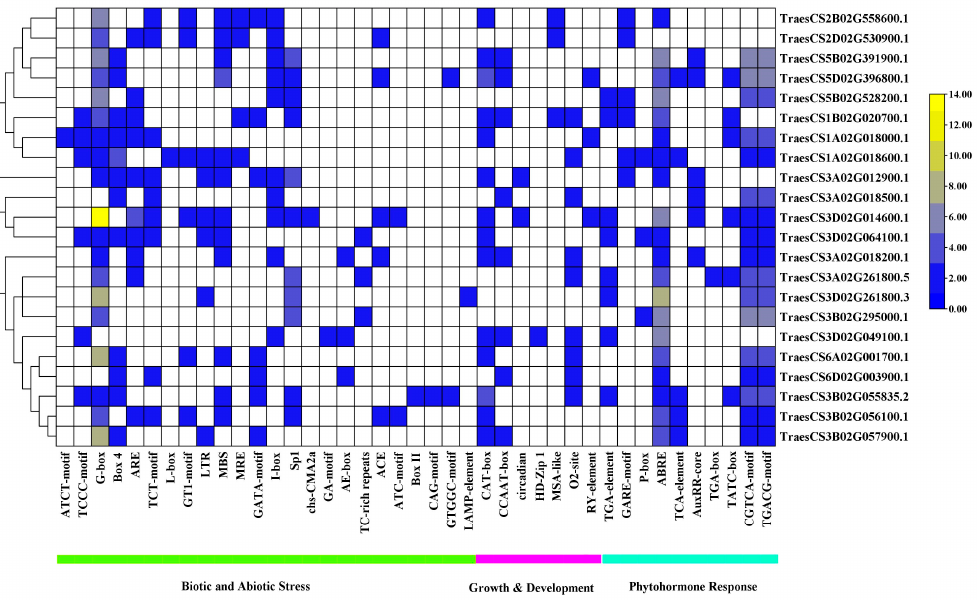
Figure 3. Cis-regulatory elements in promoter regions of TaPSTOL1 orthologs. The color patterns indicate the distribution of different cis-elements across the orthologs. Legend on the left side shows the number of cis-elements and the respective colors on the map.